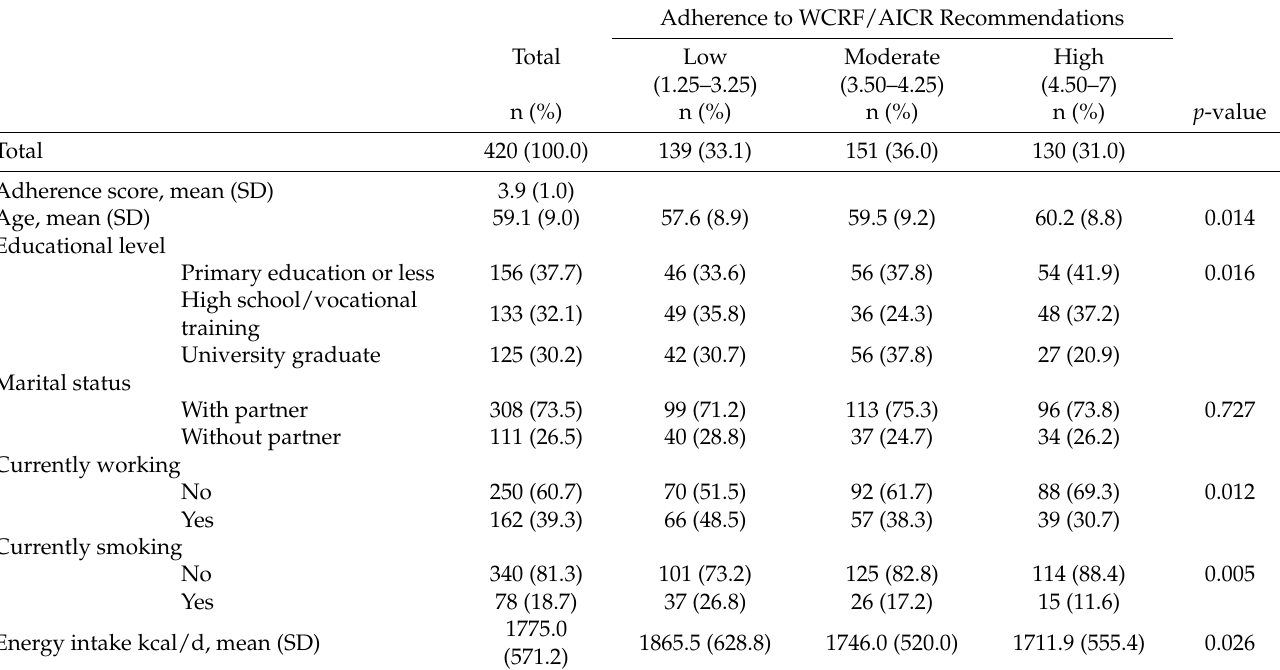
Table 2. Sociodemographic and clinical characteristics of breast cancer survivors, overall and by tertiles of the 2018 WCRF/AICR